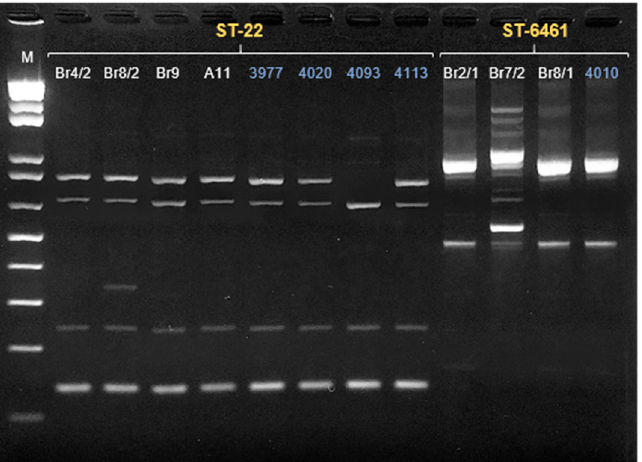
Figure 2. ERIC-PCR fingerprints of Campylobacter jejuni ST-22 and ST-6461 (presented in yellow) in a 2% agarose gel. Lane M, 1 Kbp Plus ladder (Invitrogen, Waltham, MA, USA). The ID of the sample is presented in white in the case of the dog isolates and in blue in the human isolates. Finally, a comparative gene-by-gene analysis was performed between PT isolates and other ST-6461 ( n = 91) and ST-22 ( n =83) with available genomes from different regions and sources (Supplementary Tables S1 and S2), with the results represented by minimum spanning trees (MSTs) (Figures 3 and 4).